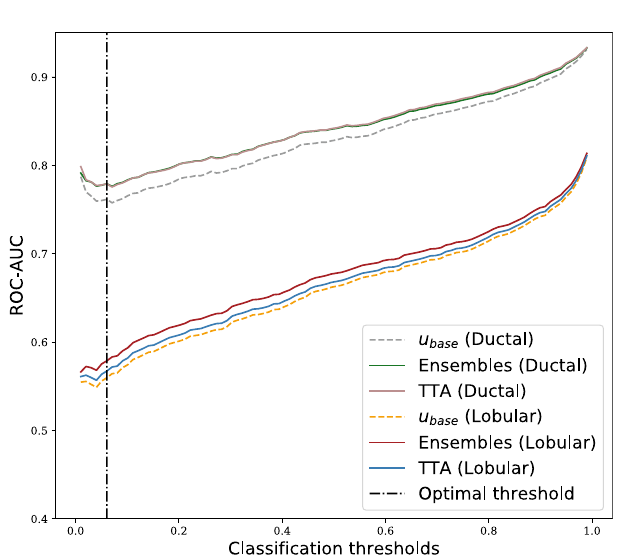
Figure 8. ROC-AUCs of misprediction detection by sample means uncertainty from ensembles and TTA (for varying classification threshold). Baseline is computed from softmax score of a single